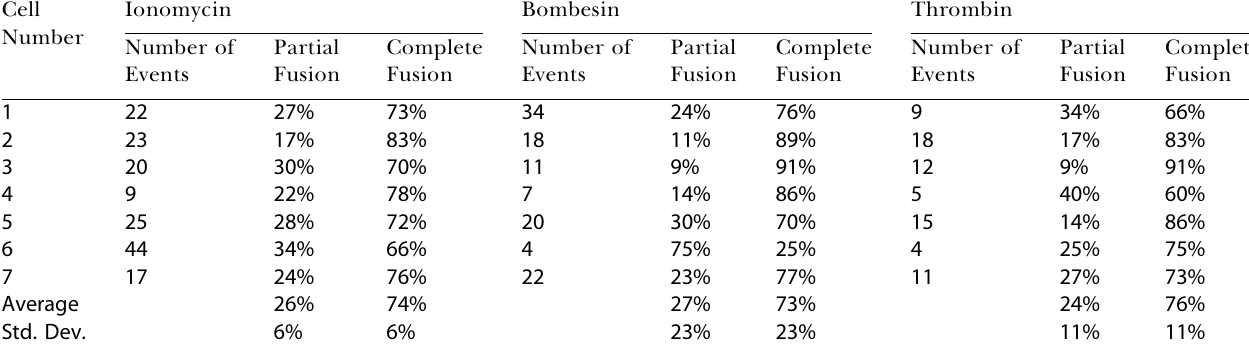
Table 1; Video S1). A comparable fraction of lysosomes, respectively, underwent partial release when calcium increase